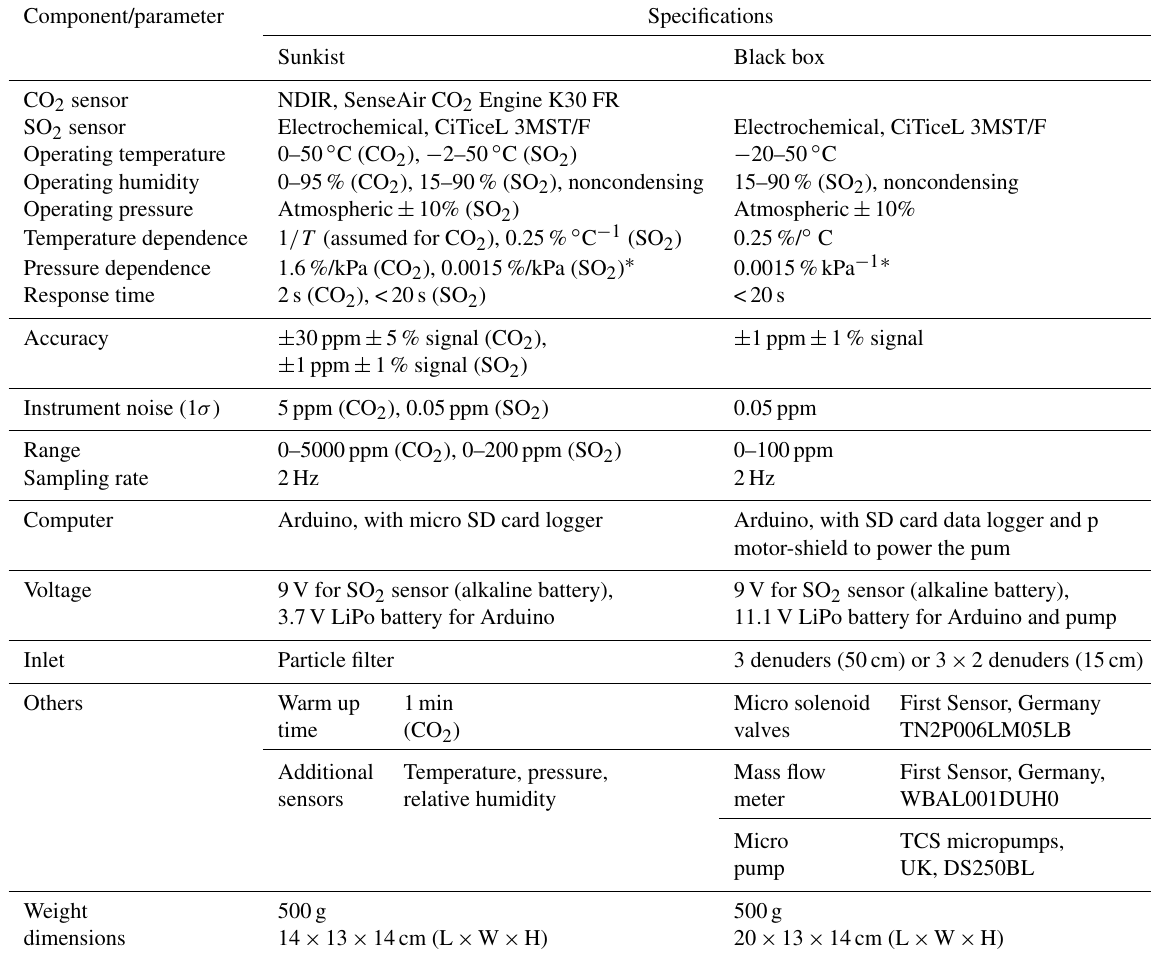
Table 1. Components and specifications of the sampling and sensing instruments.